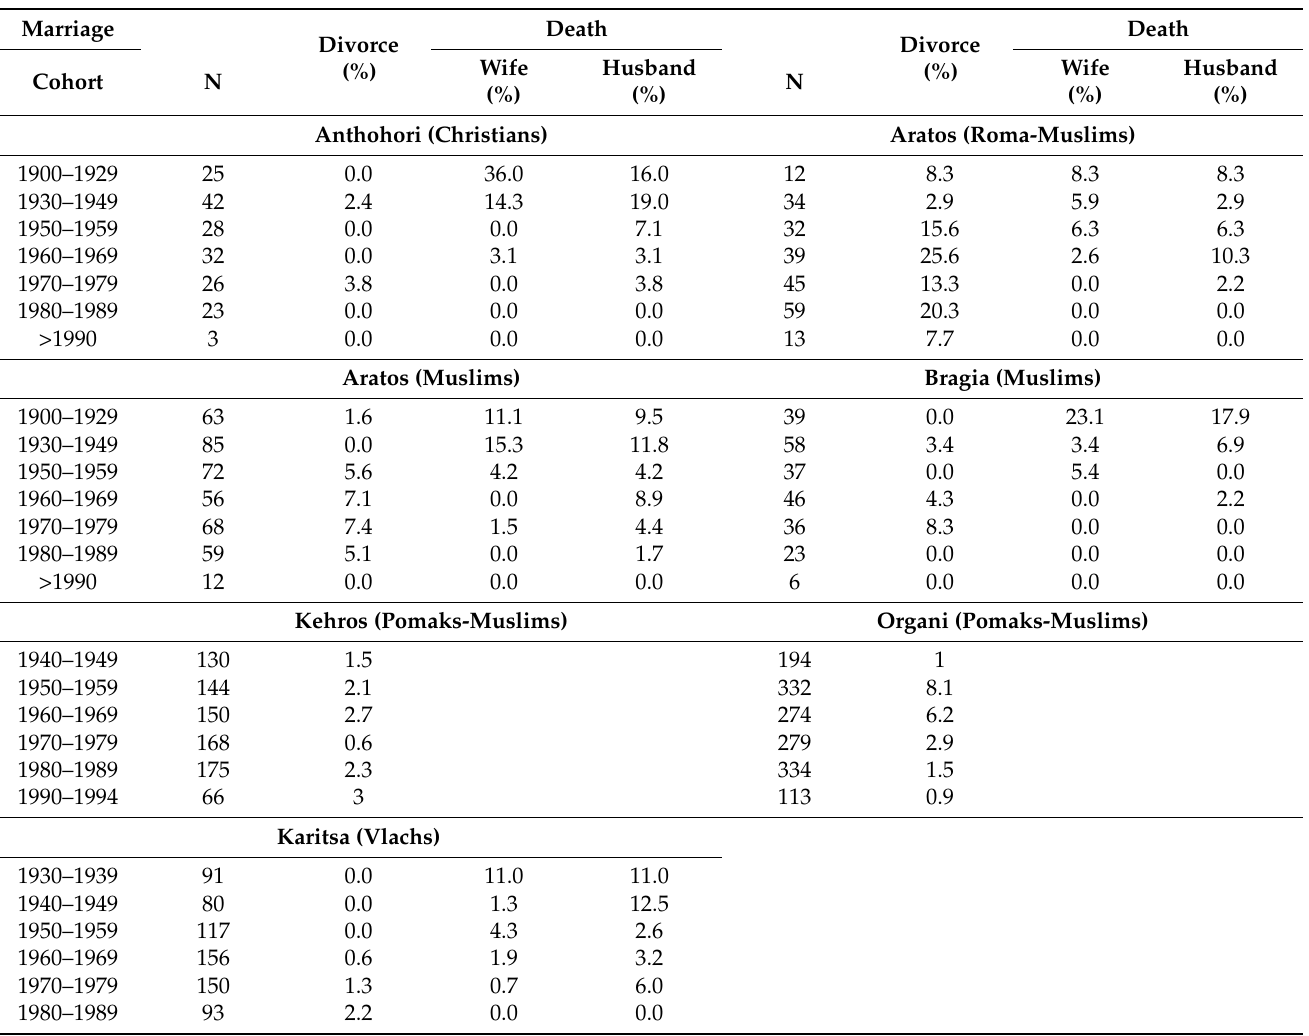
Table 4. Marriage dissolution in the sample